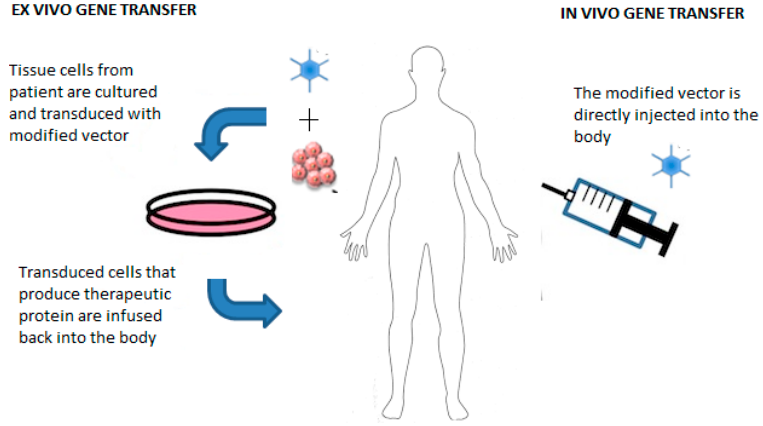
Figure 1. Schematic presentation of various approaches used for the delivery of vectors and genes for genetic